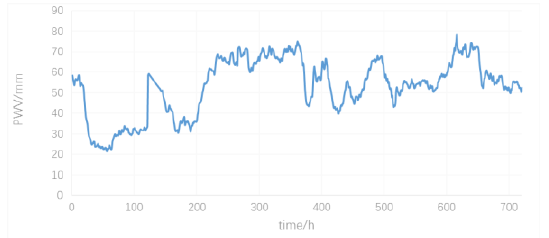
Figure 5. WUHN Station PWV